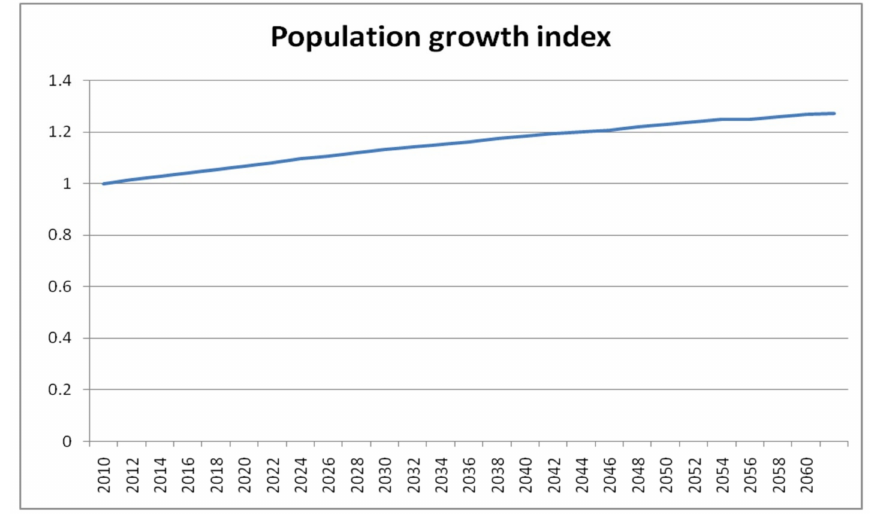
Figure 4. Population growth index